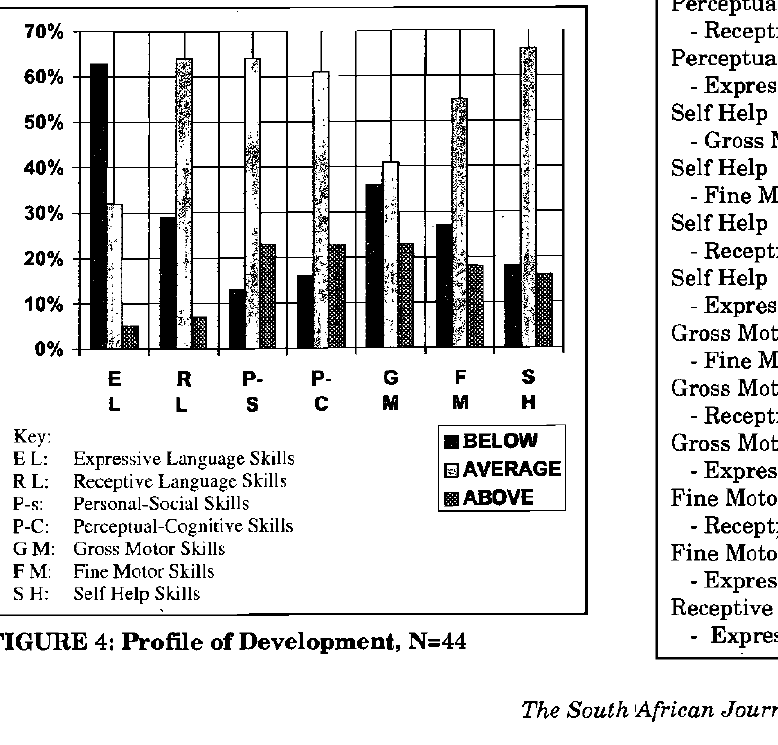
FIGURE 4: Profile of Development,